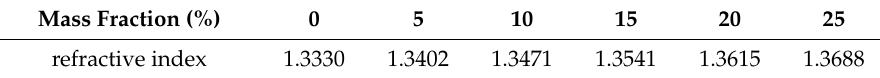
Table 1. Relationship between the mass fraction of glucose solution and refractive index. Mass Fraction (%)